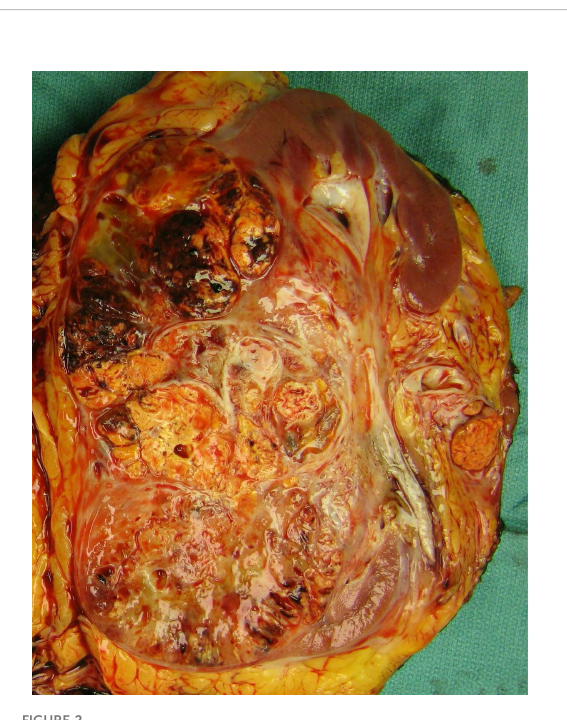
TABLE 1 Baseline